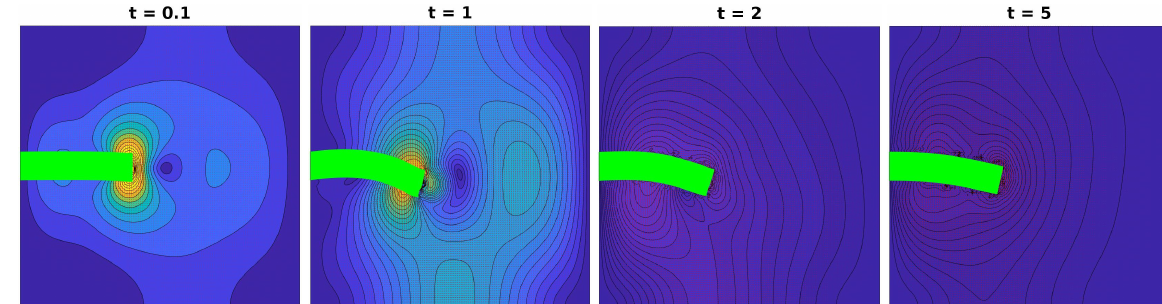
Figure 2. Four snapshots of the evolution of the structure with nonlinear constitutive law. Table 3. Refining of the mesh in the nonlinear solid model. The simulations are run on the Shaheen cluster. procs = number of processors; dofs = degrees of freedom; T ass = CPU time to assemble the stiffness and mass matrices; T coup = CPU time to assemble the coupling term; nit = Newton iterations; its = GMRES iterations to solve the Jacobian system; T sol = CPU time to solve the Jacobian system; T tot = total simulation CPU time. The quantities T coup and nit are averaged over the time steps, whereas the quantities its and T sol are averaged over the Newton iterations and the time steps. All CPU times are reported in seconds. Nonlinear Solid Model—Mesh Refinement Test procs = 64, T = 2, ∆ t = 0.002